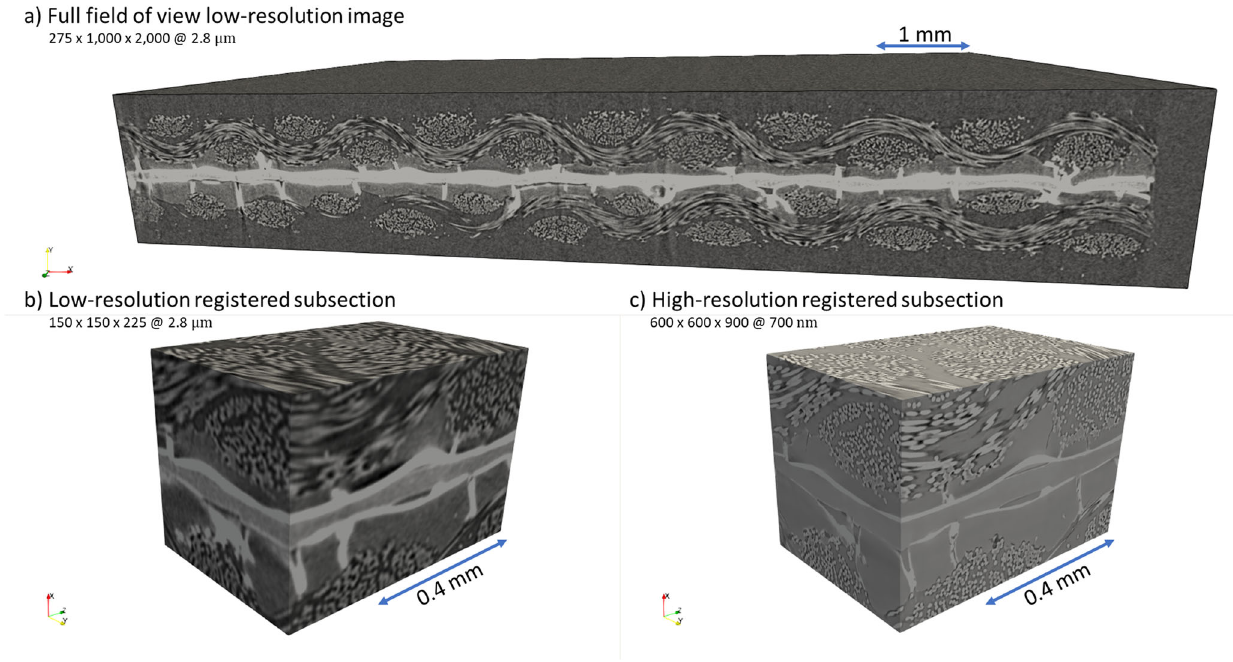
Fig. 6 | PEMFC images as obtained by μ -CT. a Full fi eld of view low-resolution (2.8 μ m) PEMFC image, and b registered low-resolution and c high-resolution (700nm) subdomains used for